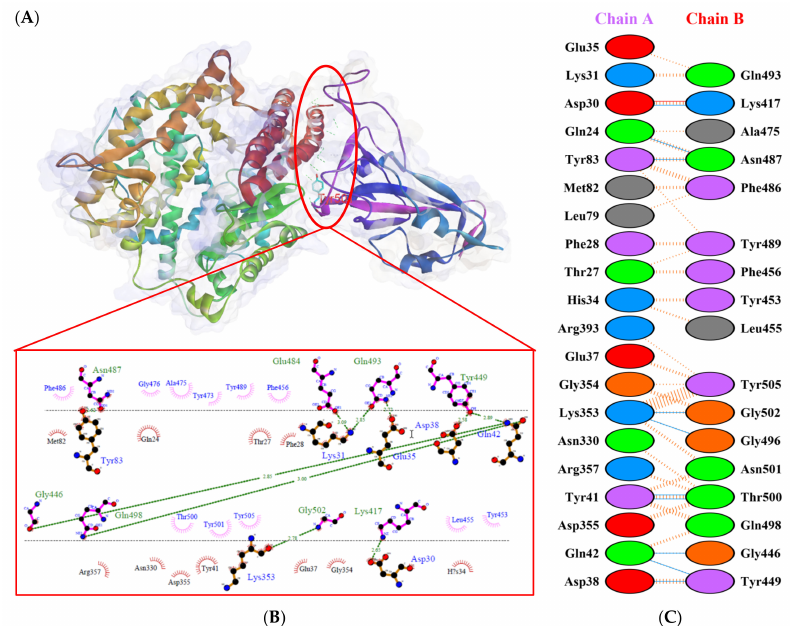
Figure 7. Protein–protein docking representation of hACE2 and RBD Alpha complexes. ( A ) The complex’s binding interface; ( B ) The amino acid’s binding interaction; and ( C ) The interaction representation, which includes hydrogen ( ), salt bridges ( ), and non-bonded ( ) interactions. Chain A represents hACE2 and chain B represents RBD Alpha. Residue colors: positive (blue): H,K,R; negative (red): D,E; neutral (green): S,T,N,Q; aliphatic (grey): A,V,L,I,M; aromatic (purple): F,Y,W; Pro & Gly (orange): P,G.